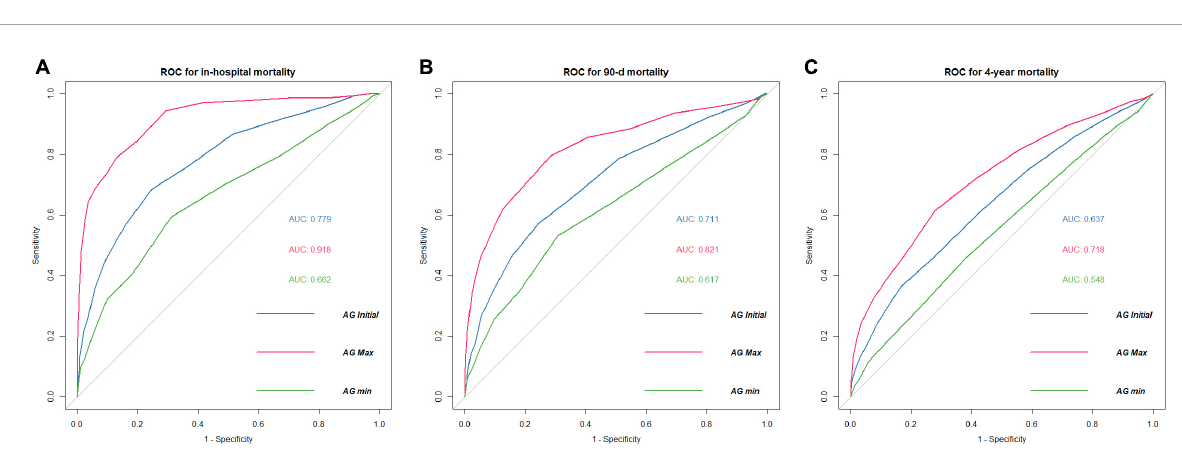
FIGURE4 ROC curves of postoperative serum AG for mortality. (A) In-hospital mortality (B) 90-day mortality (C) 4-year mortality. AUC, area under curve; ROC, receiver operating characteristic; AG Initial, the initial value of AG after surgery; AG Max, the maximum value of AG during postoperative ICU stay; AG Min, the minimum value of AG during postoperative ICU